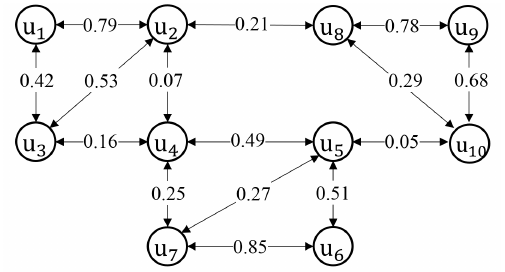
Figure 1. The social